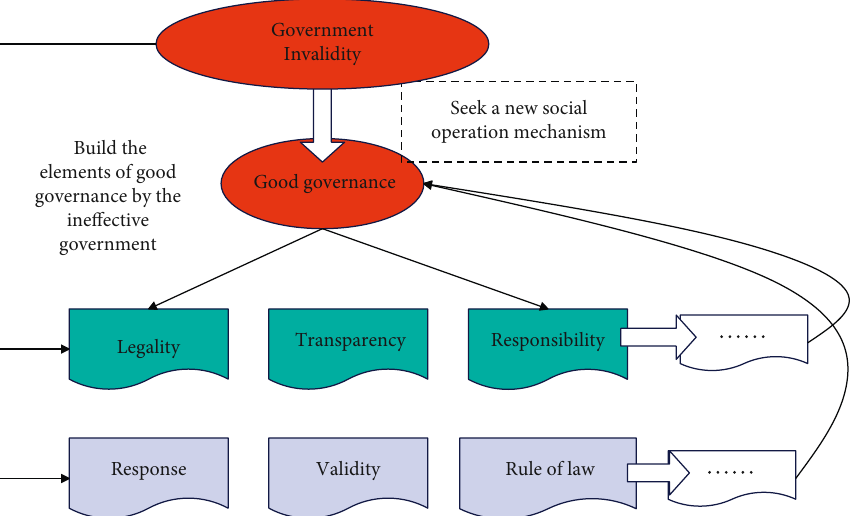
Figure 6: The logic of governance